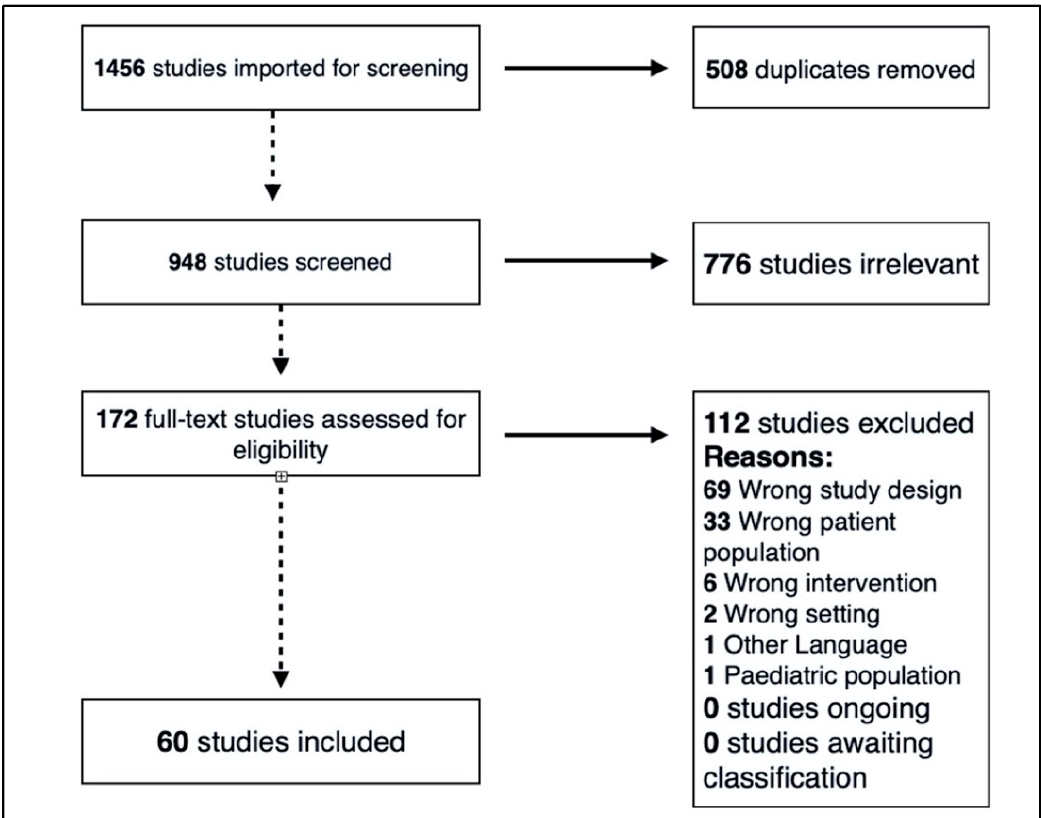
Figure 1. Preferred Reporting Items for Systematic Reviews and Meta-Analyses (PRISMA) flow diagram of literature search and selection process.